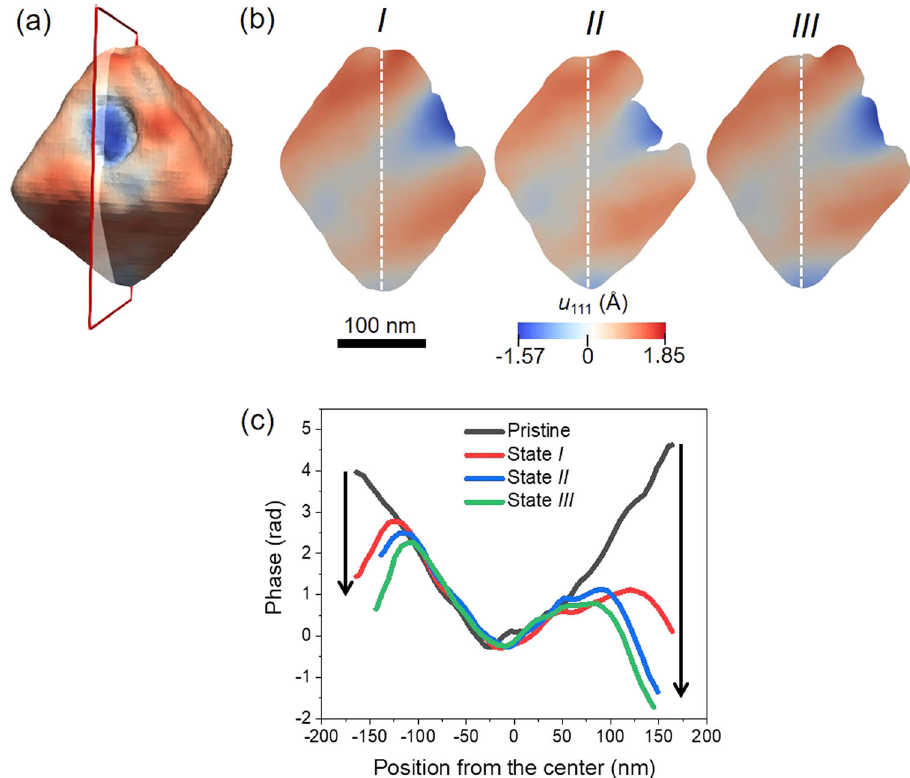
Fig. 6 Cross-sectional views of the phase distribution for states I – III . a 3D reconstruction with the transparent plane representing the position of the cross-sections shown in ( b ) for states I – III . c Phase plotline over the dashed white line shown in ( b ) for states I – III . The black arrows at the sides of the plot show the direction of the phase